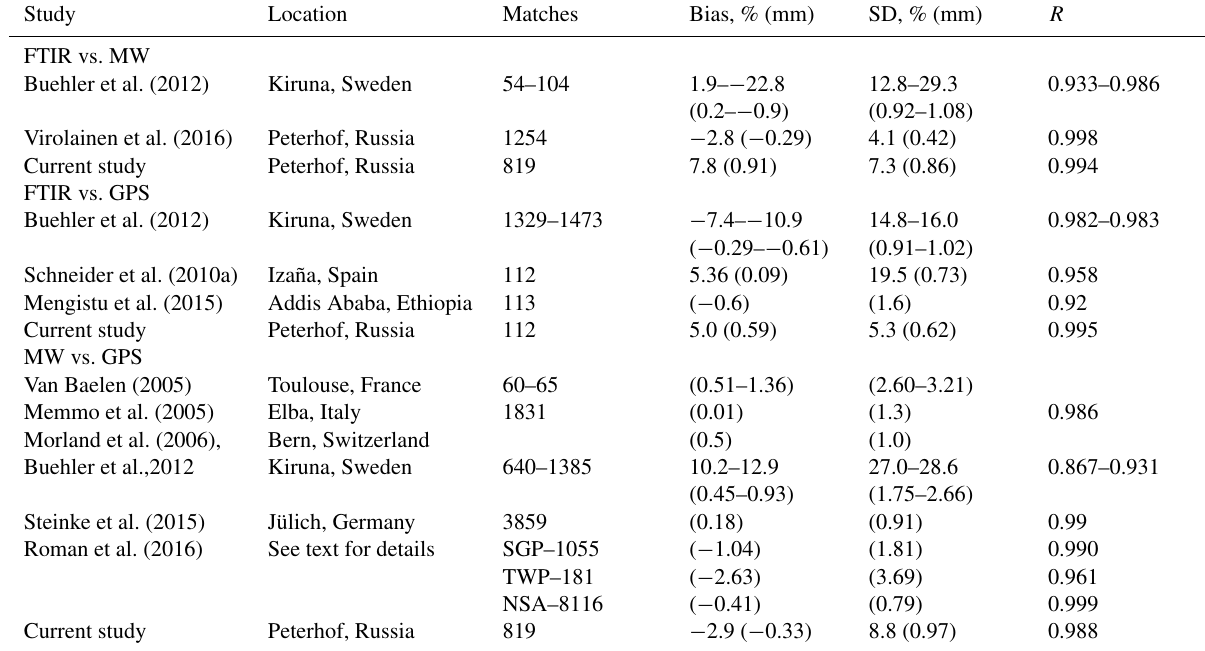
Table 7. Some results of IWV comparisons as reported by different authors. SD is the SD of mean differences; R is the correlation coefficient. Study Location Matches Bias, % (mm) SD, % (mm) R FTIR vs. MW Buehler et al.